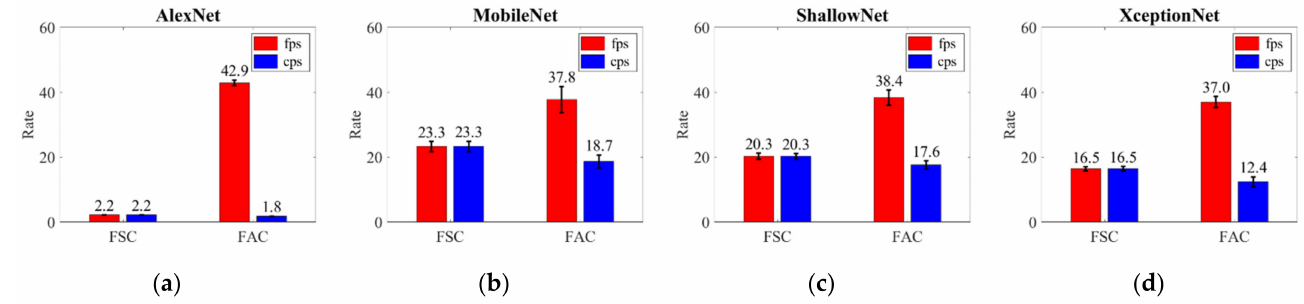
Figure 9. Result of ultrasound image frame rate (fps) and classification rate (cps, classification per second) during ultrasound image reconstruction with DLN inference. Frame and classification rates are represented as bar graphs with average value and variance according to frame synchronization in ( a ) AlexNet, ( b ) MobileNet, ( c ) ShallowNet, and ( d )